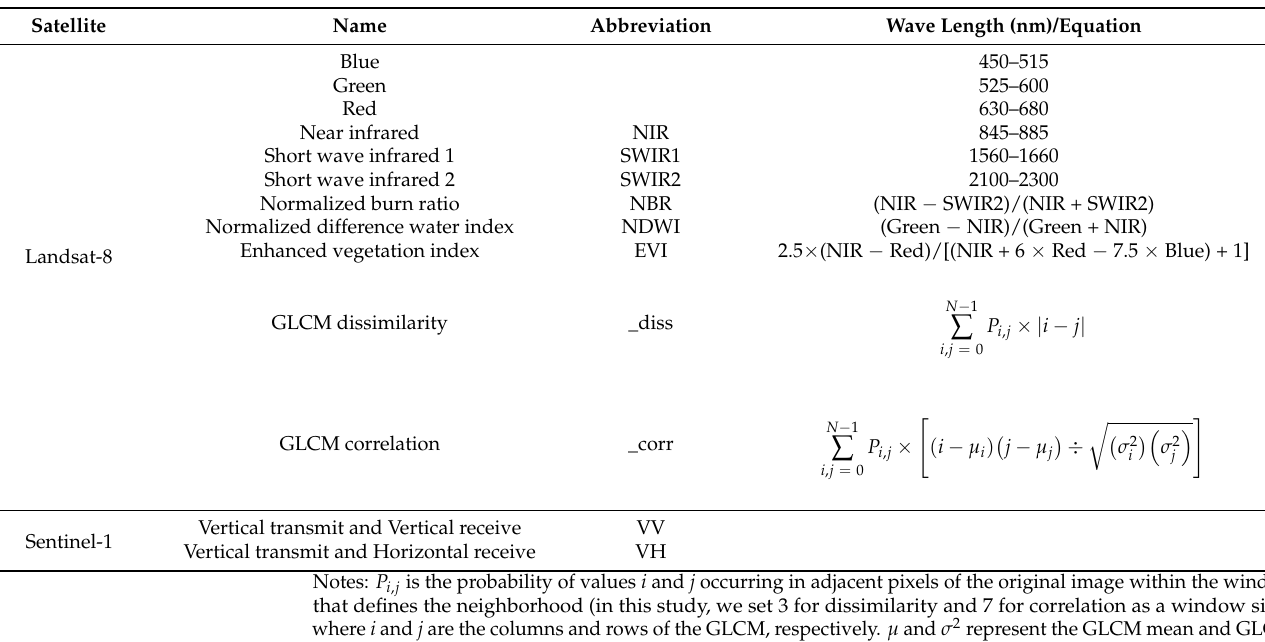
Table 1. List of the used satellite-derived